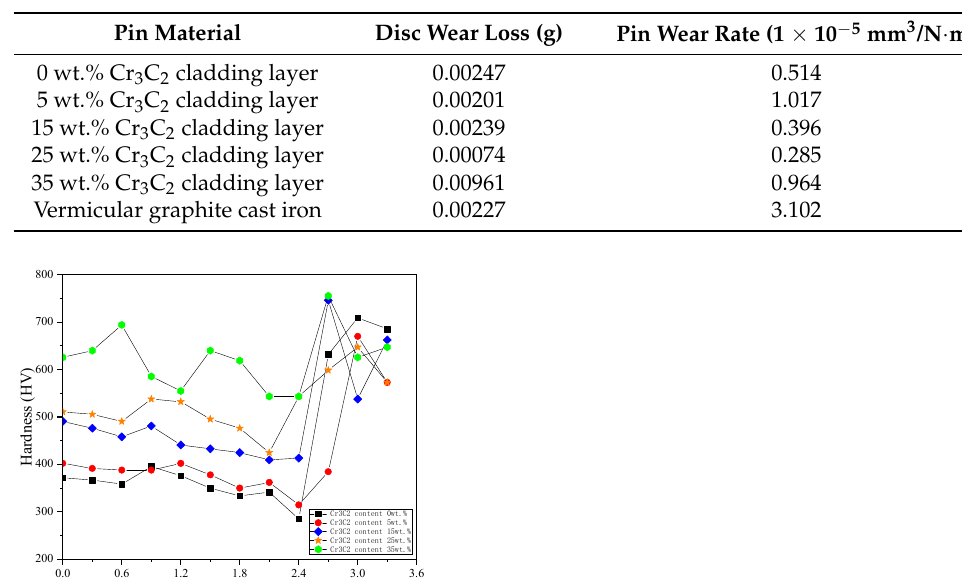
Table 4. Pin and disc wear loss of different pin material groups.